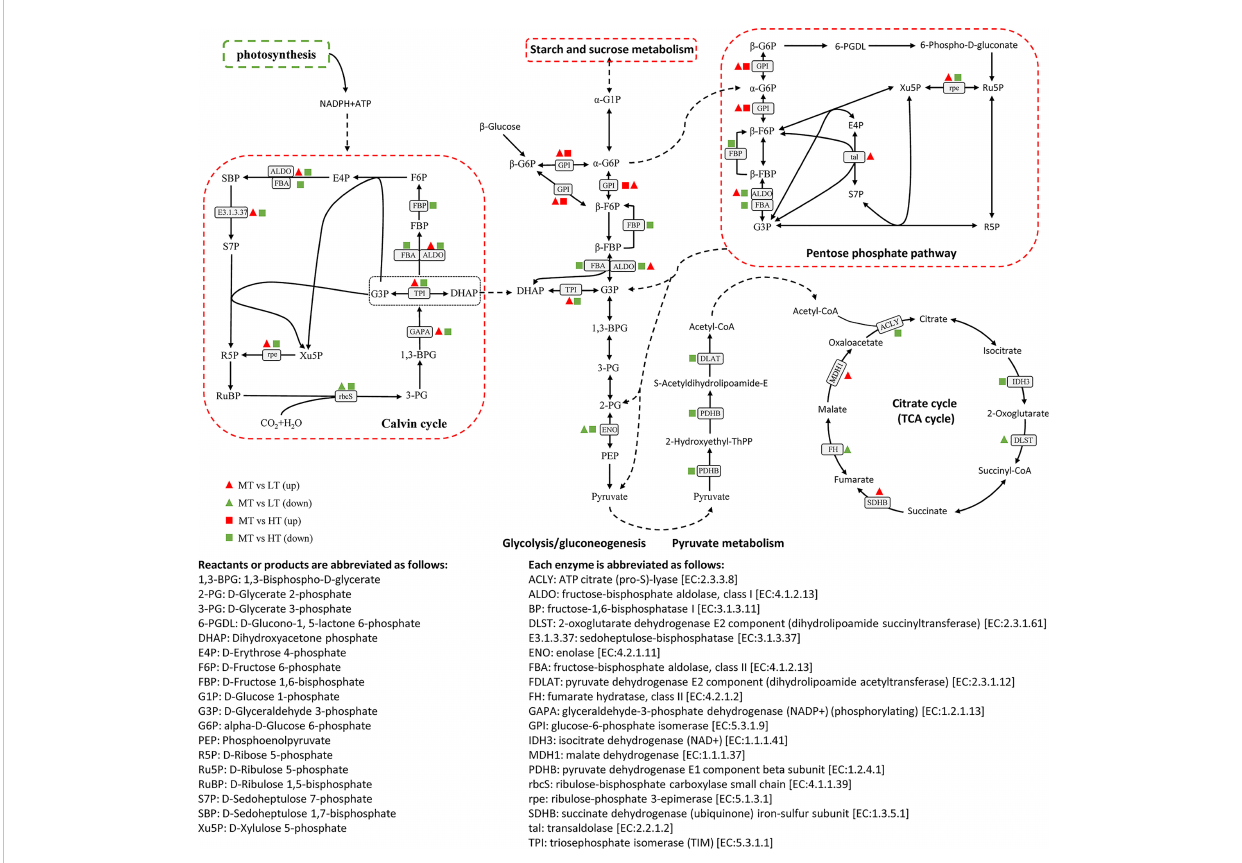
FIGURE 4 Pathways of carbon fi xation in photosynthetic organisms, glycolysis/gluconeogenesis, pyruvate metabolism, pentose phosphate, and citrate cycle (TCA cycle). Detailed descriptions of the DEGs are included in Supplementary Table